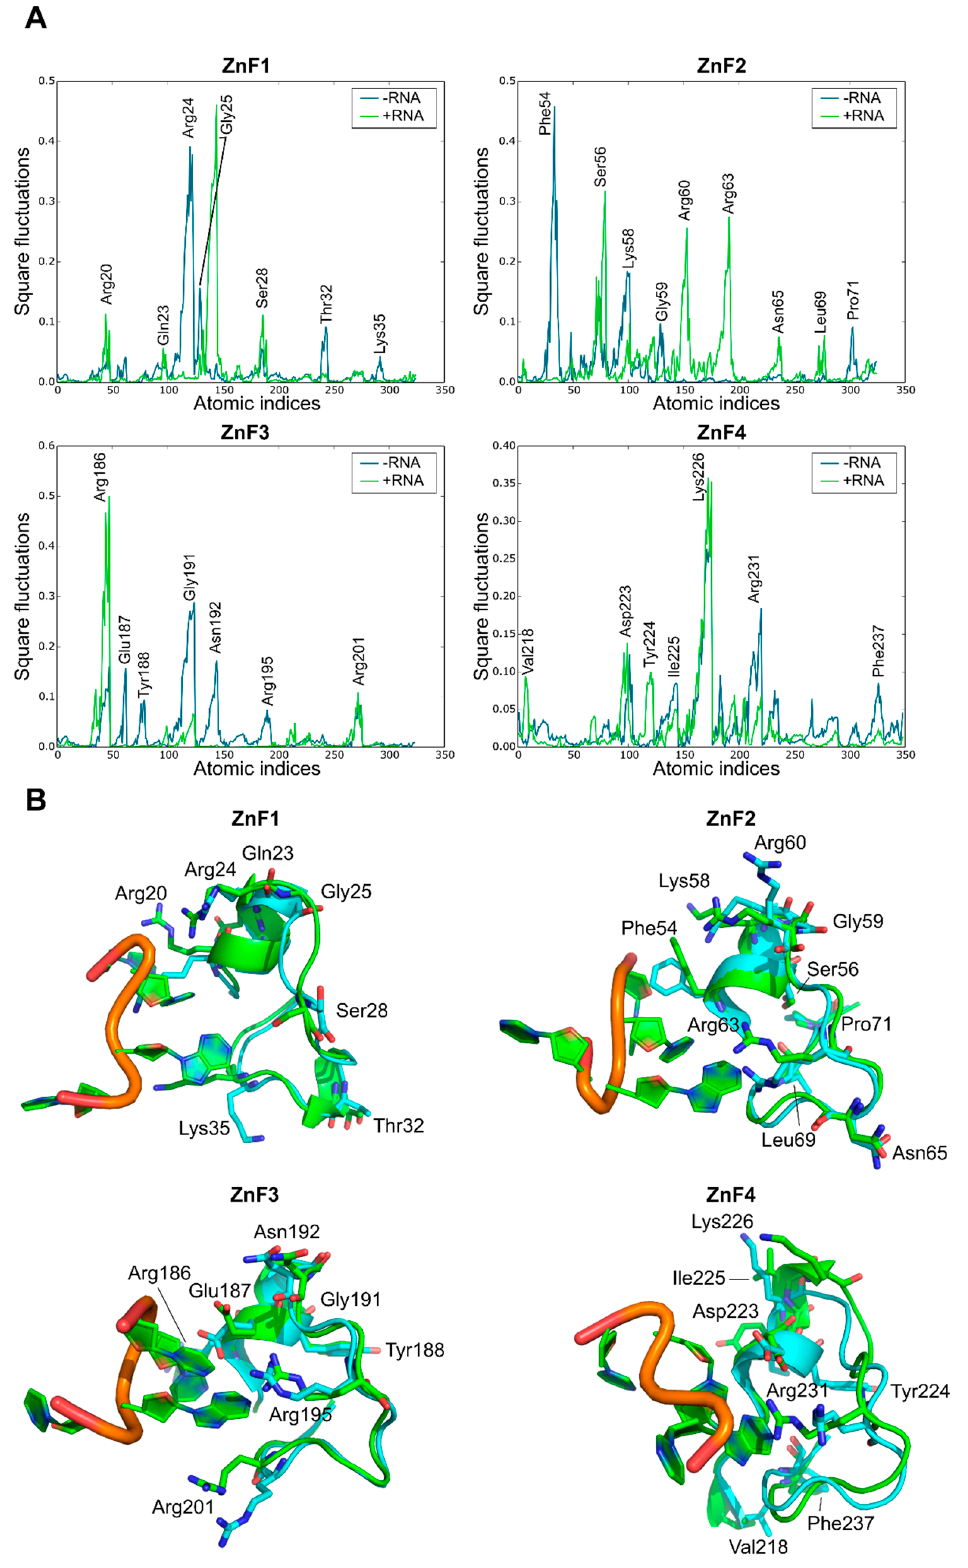
Figure 5. Effect of RNA binding on local fluctuations of MBNL1 ZnFs. ( A ) Local fluctuations extracted from the MD simulations for each domain alone ( − RNA) or bonded to RNA (+RNA). Only the atomic indices of the RNA binding site are represented (ZnF1: 18 to 38; ZnF2: 52 to 72; ZnF3: 184 to 204; and ZnF4: 218 to 238). ( B ) Relevant fluctuating amino acids in an unbound (blue) and bound (green)